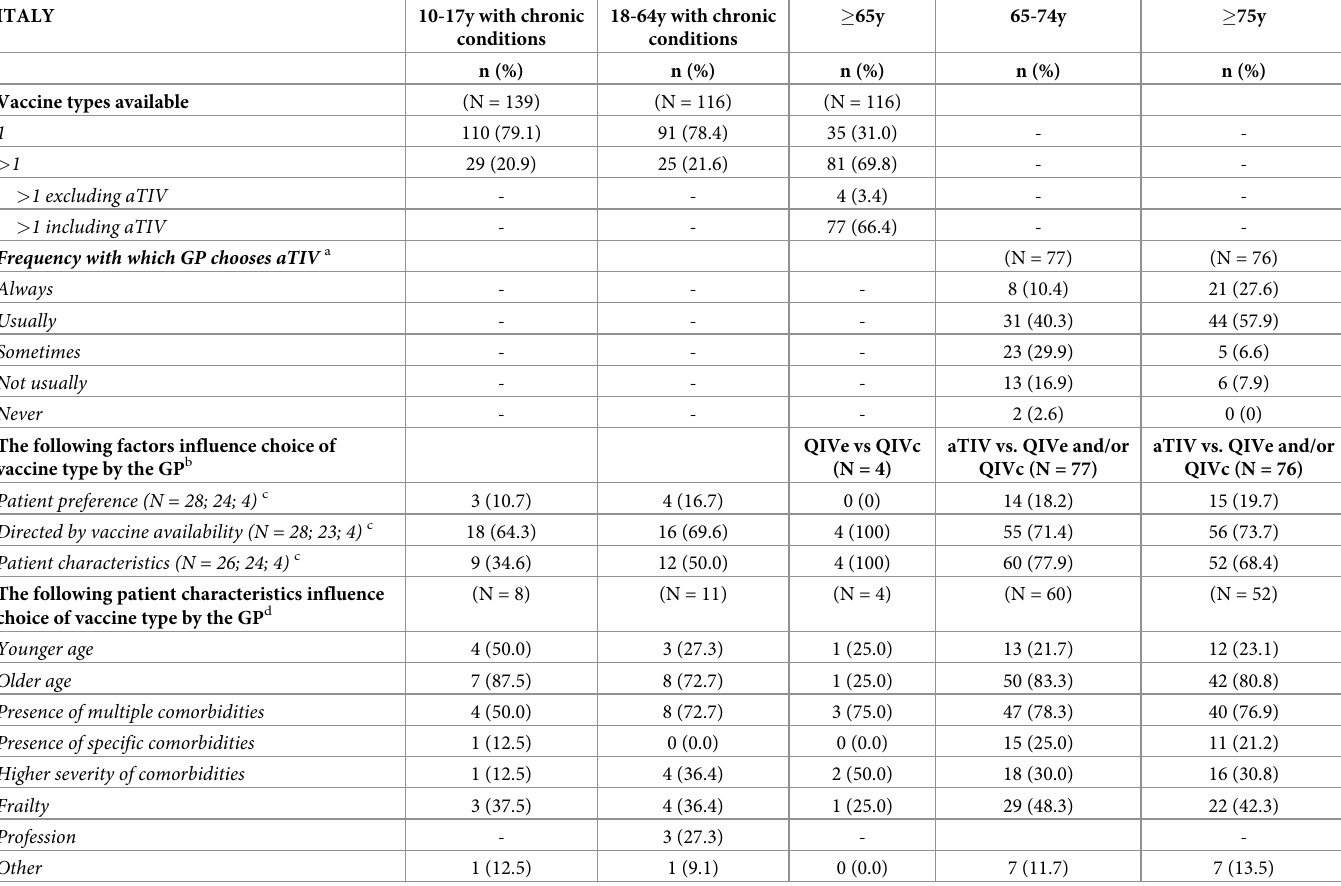
Table 5. Vaccine type availability and factors that influence choice of vaccine type by the GP in 2019/2020, by risk group, Italy.